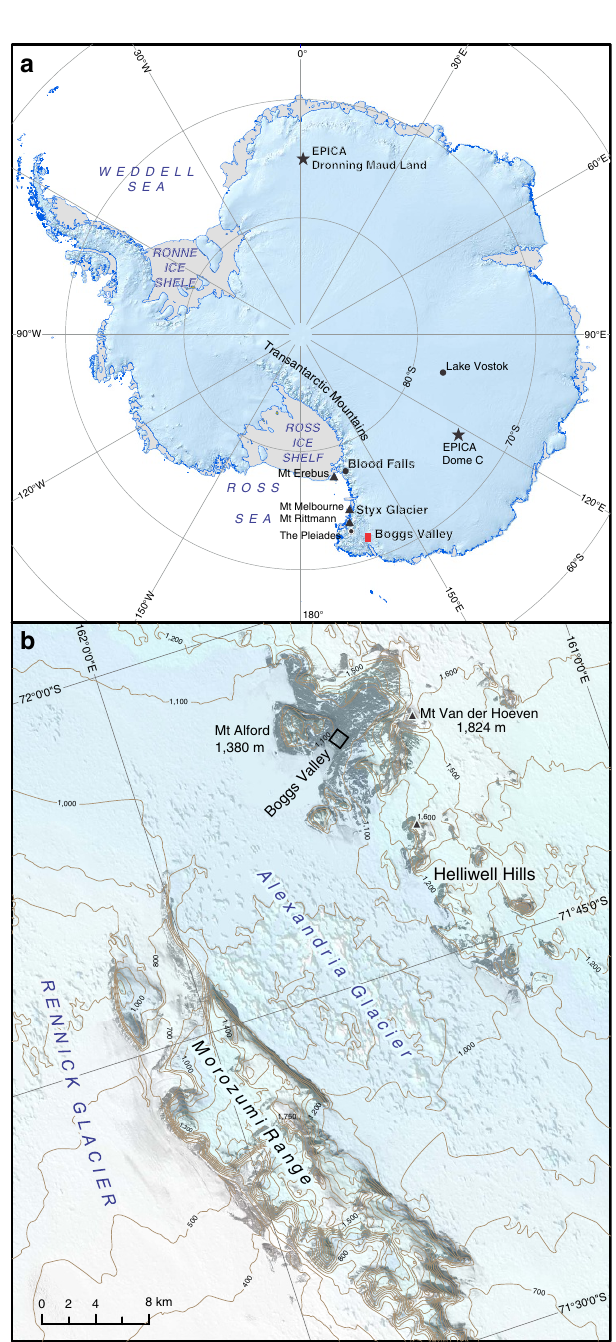
Figure 1 | Boggs Valley location, sampling area and geomorphologic context. ( a ) Map of Antarctica with location of Boggs Valley and other sites mentioned in the text; Talos Dome is located circa 100km south of the sampling site. ( b ) Map created with ASTER GDEM data (by METI and NASA), showing contours. These highlight that Boggs Valley connects the Ice-Sheet plateau with the Alexandria Glacier, whose surface has a lower elevation relative to the valley floor. The Alexandria merges with the Rennick, one of the largest outlet glaciers in NVL. The open square marks the area where subglacial calcite samples were collected from glacially polished rock